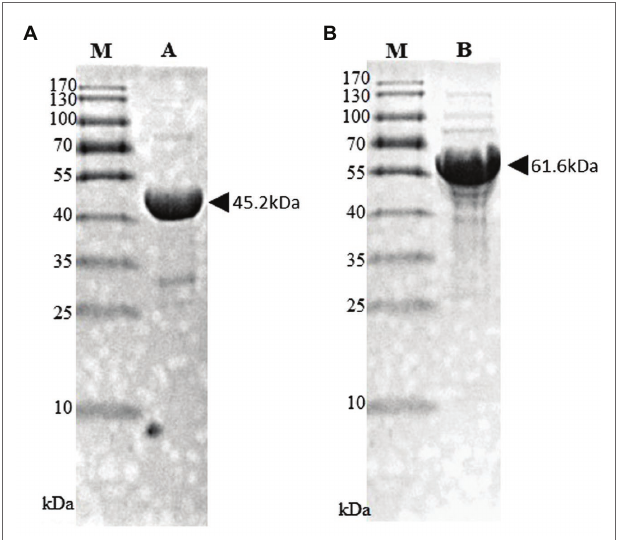
FIGURE 2 | SDS-PAGE analysis of purified His-tagged PnPKS (A) and 4CL2nt (B) . Purified His-tagged PnPKS (Lane A; 45.2 kDa) and 4CL2nt (Lane B; 61.6 kDa) protein after affinity purification. M, protein size